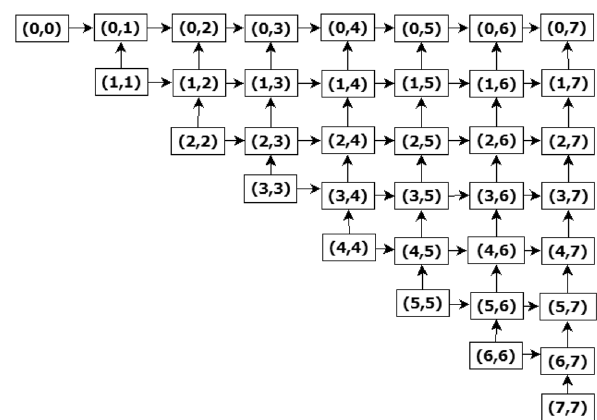
Fig. 3 Dynamic programming table or tasks graph for n = 7